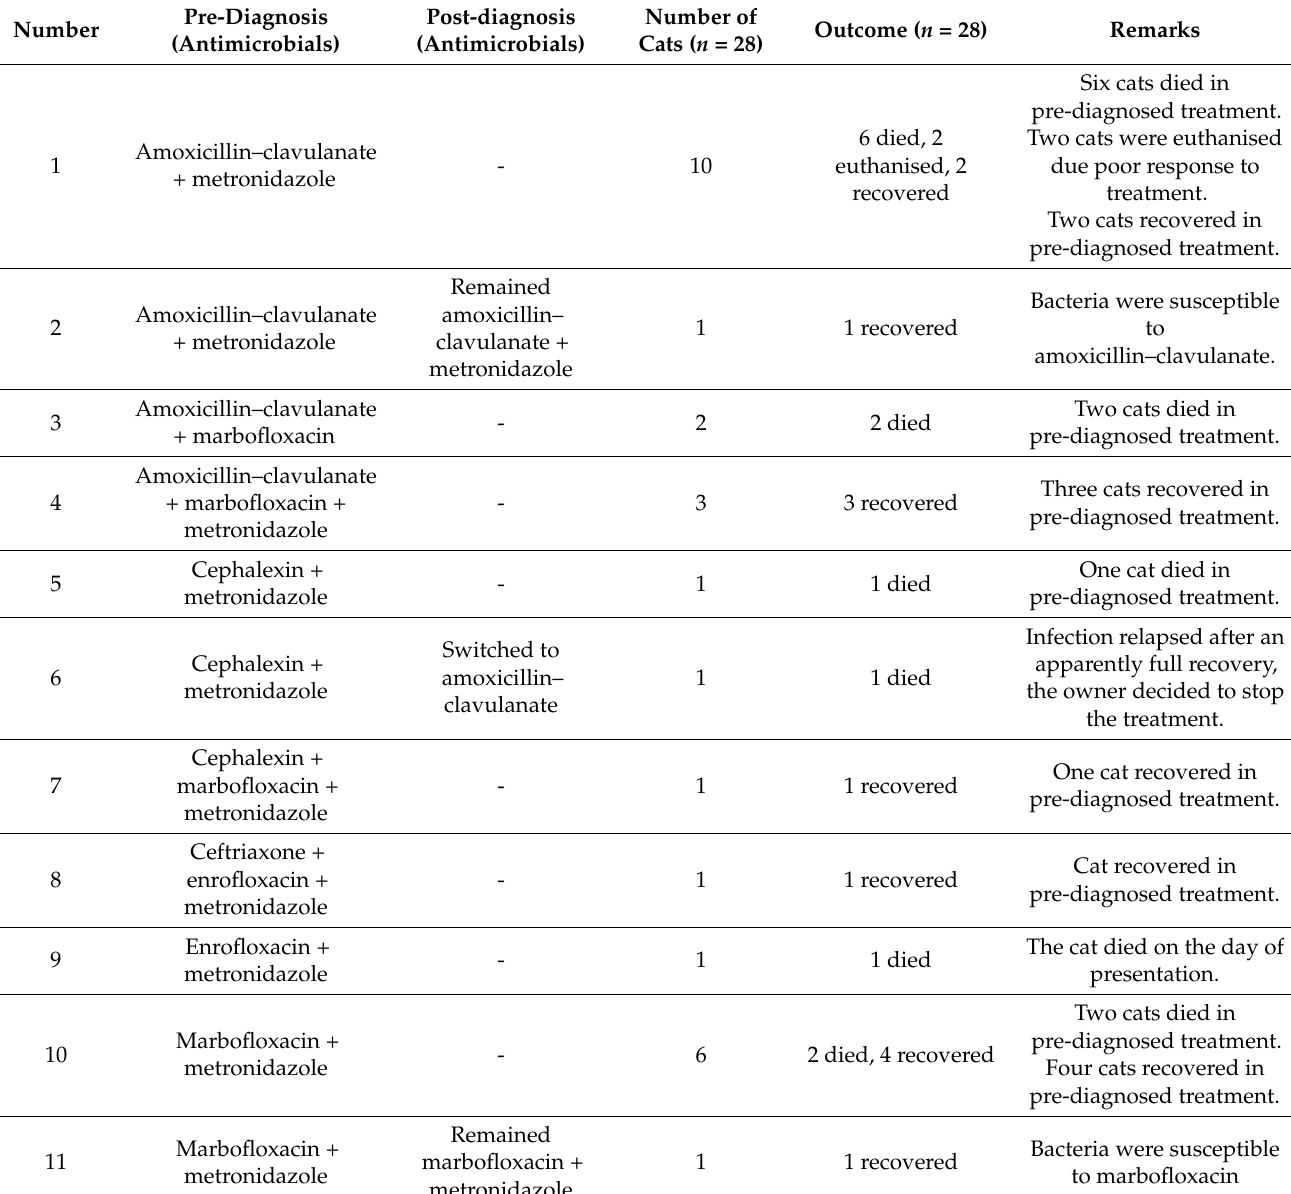
Table 10. Summary of antimicrobials used in the treatment of 28 pyothorax